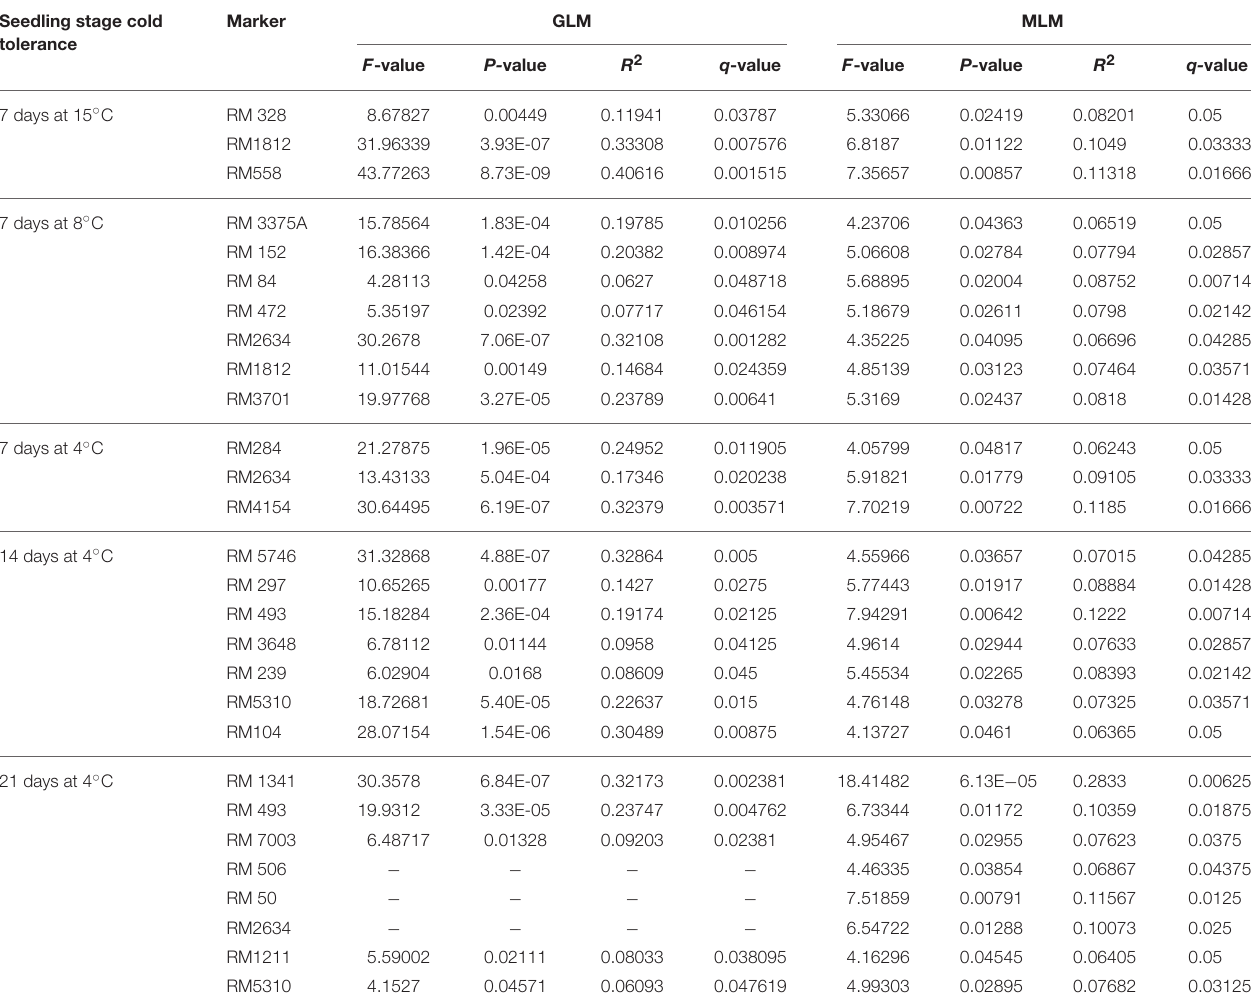
TABLE 6 | Association of marker alleles with seedling stage cold stress tolerance showing. Seedling stage cold tolerance